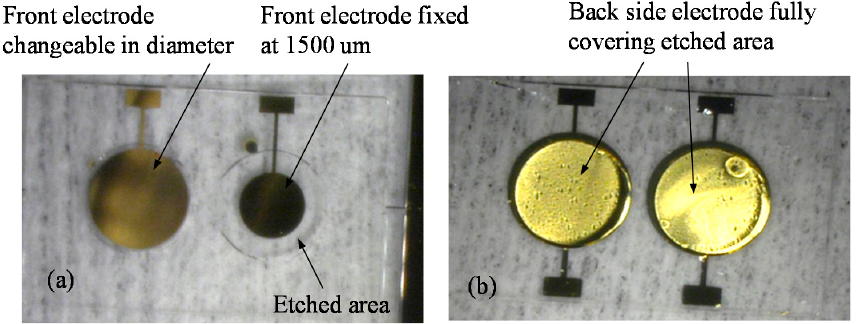
Figure 3. Example images of the fabricated dual-channel QCM chip: ( a ) Front view; ( b ) Back view.